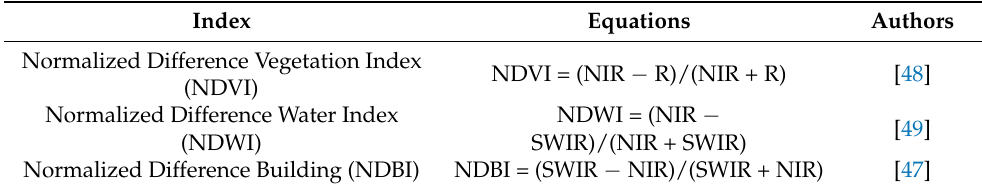
Figure 11. Variables associated with SUHI and LCZ used in the articles reviewed. Table 5. Equations of principal spectral indexes used in the articles Table 5. Equations of principal spectral indexes used in the articles reviewed.